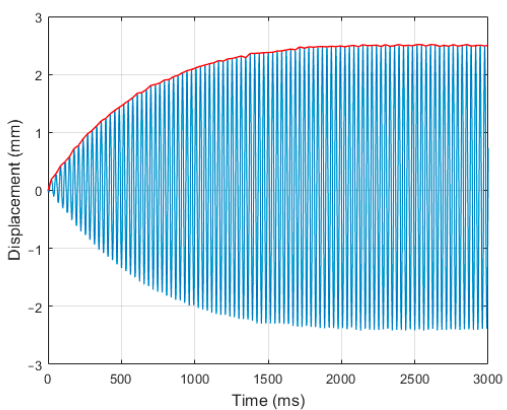
Figure 8. Measured displacement of point No. 10 for resistance equal to 65 k Ω . In the second stage, absolute values of the displacement of nine points were calculated for 10 values of resistance. Comparison of the absolute values of the displacements of exemplary point No. 10 for 10 values of the shunt resistance are presented in Figure 9.